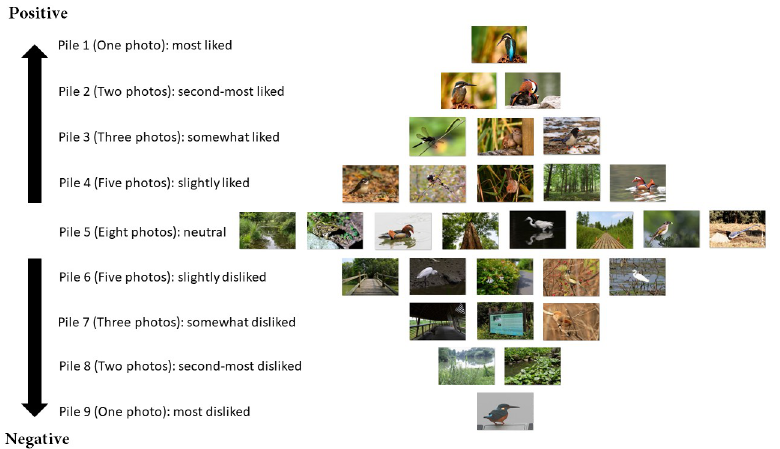
Fig 1. The structure of a Q sort. An example of how the photographs were grouped into the nine piles by a certain participant (Q sorting). Piles represented different attitudes towards the photographs. The completed Q sort was, therefore, a diamond shape, reflecting a template of a normal distribution. Due to copyright restrictions, some photographs here figure are similar but not identical to the original photographs used in the Q set and is therefore for illustrative purposes only. All the photographs included in this figure are taken by the author (Lei Zhu).